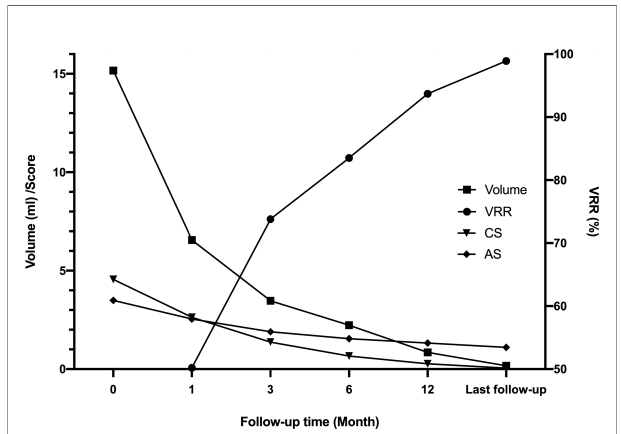
Values are presented as mean ± SD or percentage. MWA, microwave ablation.